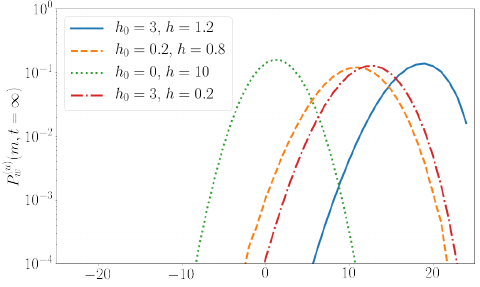
( m , ∞ ) for a subsystem of size w